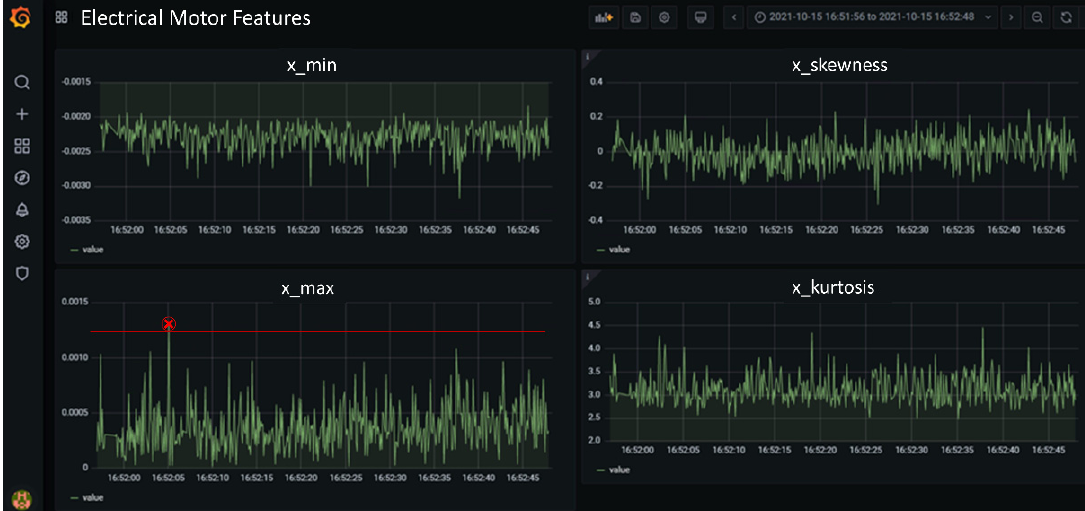
Figure 5. Descriptive statistics monitoring of the electrical motor.